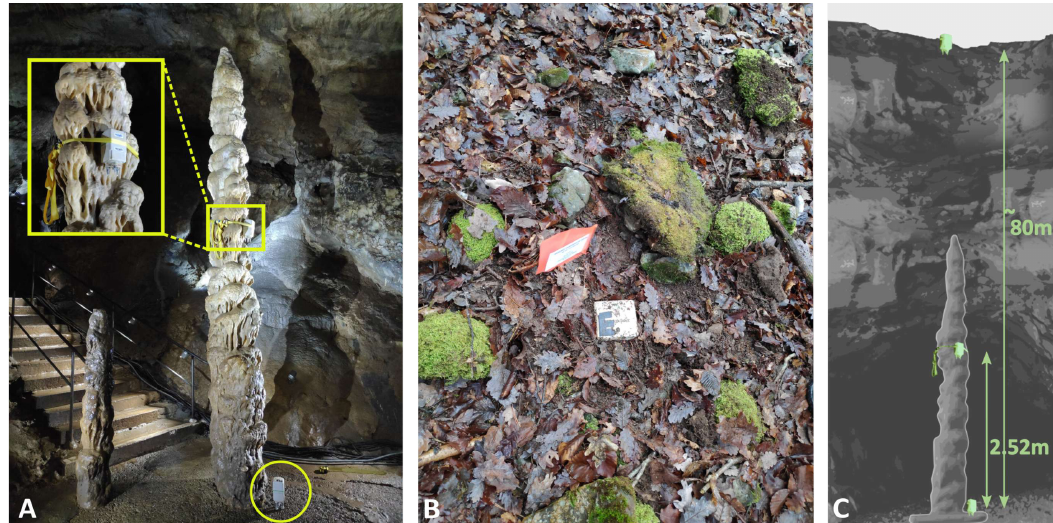
Figure 3. Three-component seismic sensors placed for the study of the natural frequency of the Minaret. ( a ) The two sensors in the cave: with a yellow ratchet strap on the Minaret and placed on the ground next to the stalagmite. ( b ) The sensor at the surface, in the soil at the vertical of the Minaret stalagmite. ( c ) Sketch of the relative position of the three sensors (not to scale in the vertical direction). Spectral analysis of the seismic records was achieved by moving windows of 30 min